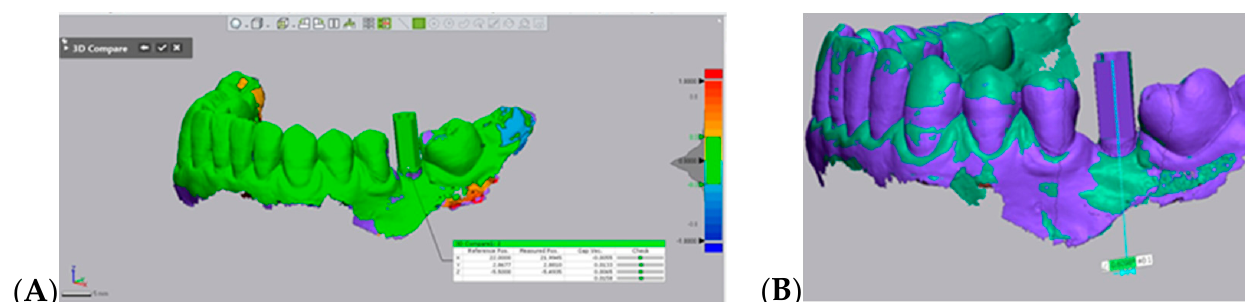
Figure 5. Precision assessment: S1 (digital scan at implant insertion) was compared with S2 (digital scan for final prosthetic manufacturing) in Geomagic Control X software. ( A ) 3D measurements at marginal border; ( B ) Angular deviation measurement.